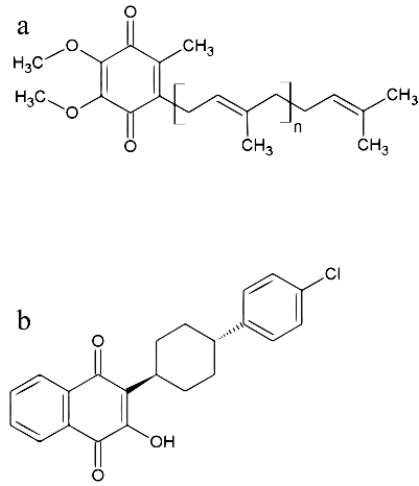
Figure 6. Chemical structures of ubiquinone and atovaquone. ( a ) Chemical structures of UQ, n indicates variable number of isoprenic units contained on the prenylquinone side chain. ( b ) The antiparasitic drug atovaquone.